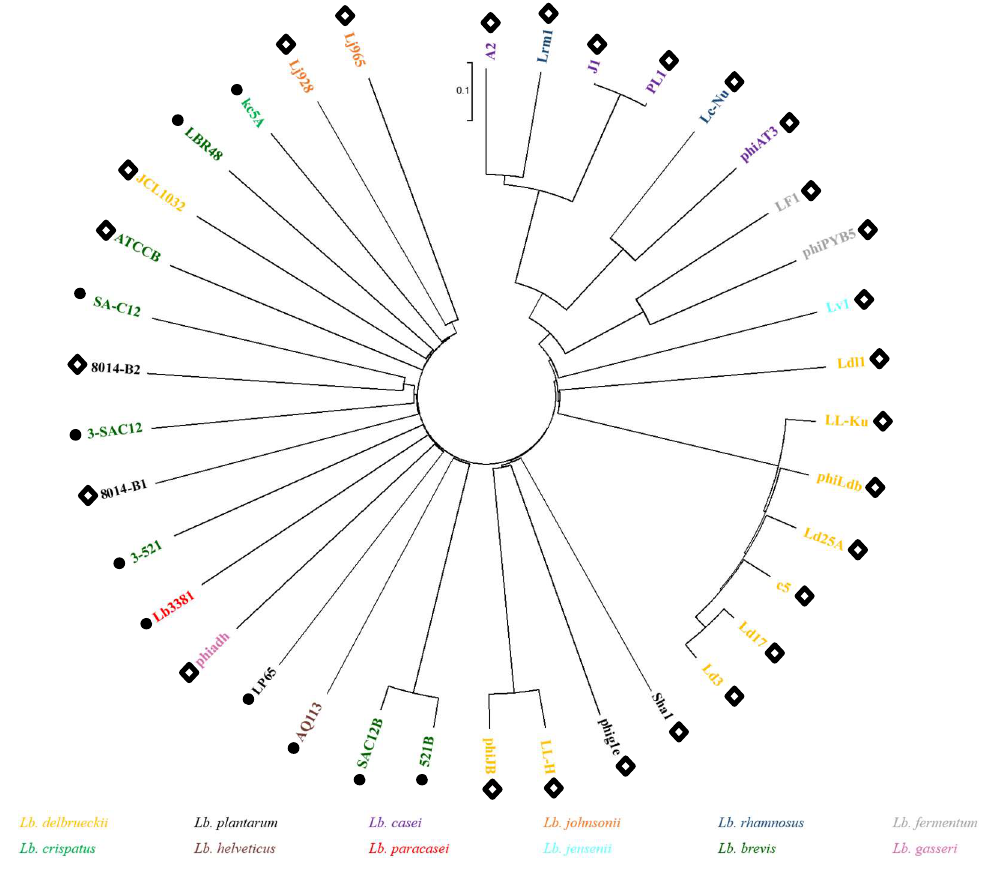
Figure 2. Proteomic tree of all Lactobacillus phages sequenced to date. Colour coding indicates the host species for each phage. Black circles indicate Myoviridae phages, while white diamonds indicate Siphoviridae phages.